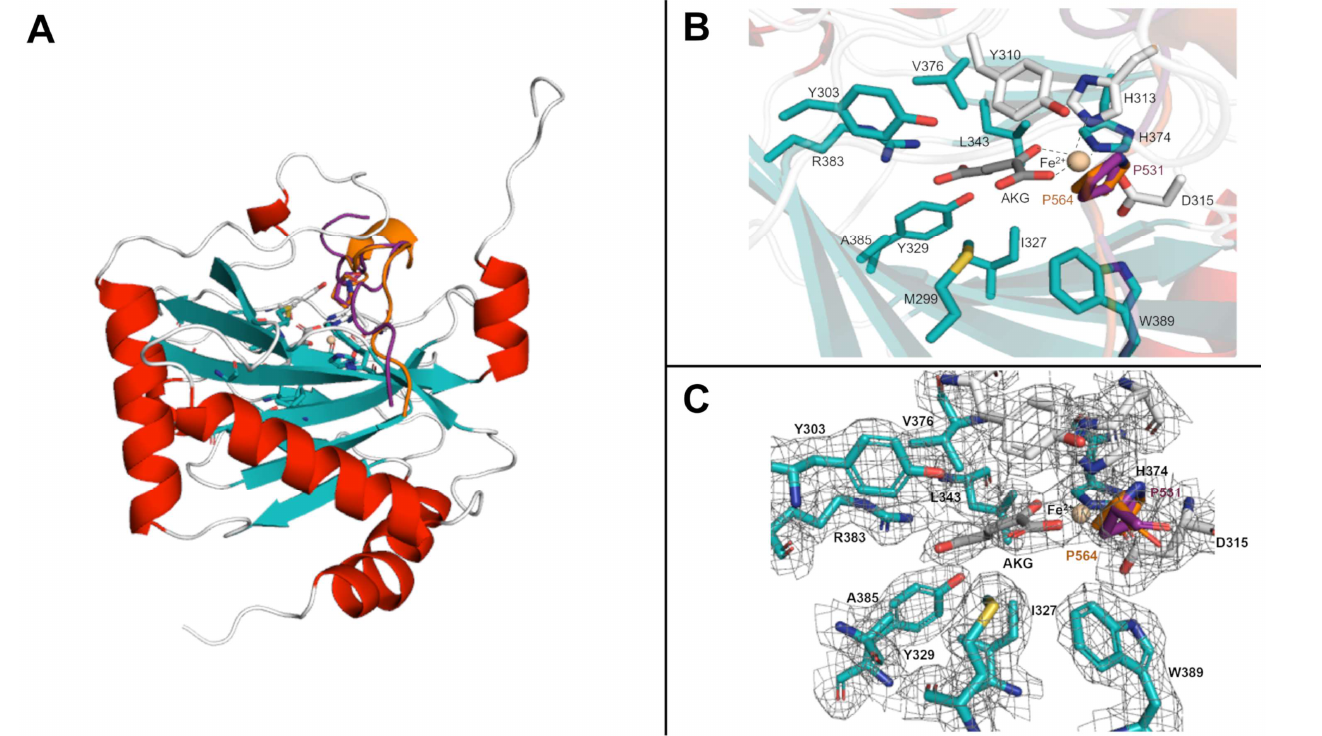
Figure 1. Overview of PHD2 structure. ( A ) A cartoon representation of the PHD2 enzyme in complex with its targets. The HIF-1α peptide is represented in orange, while purple is for the HIF-2α peptide. ( B ) A zoomed-in view of the PHD2 catalytic site. Key residues for substrate binding and enzymatic activity are presented as sticks. ( C ) A mesh view highlighting the PHD2 binding site in complex with the HIF-s substrates and co-substrate α-ketoglutarate (AKG).